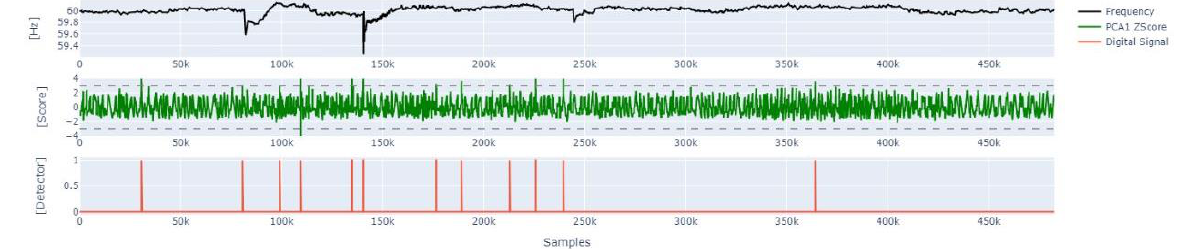
Figure 13. Event 2: detector event of PMU Apucarana (located at north of Parana State).